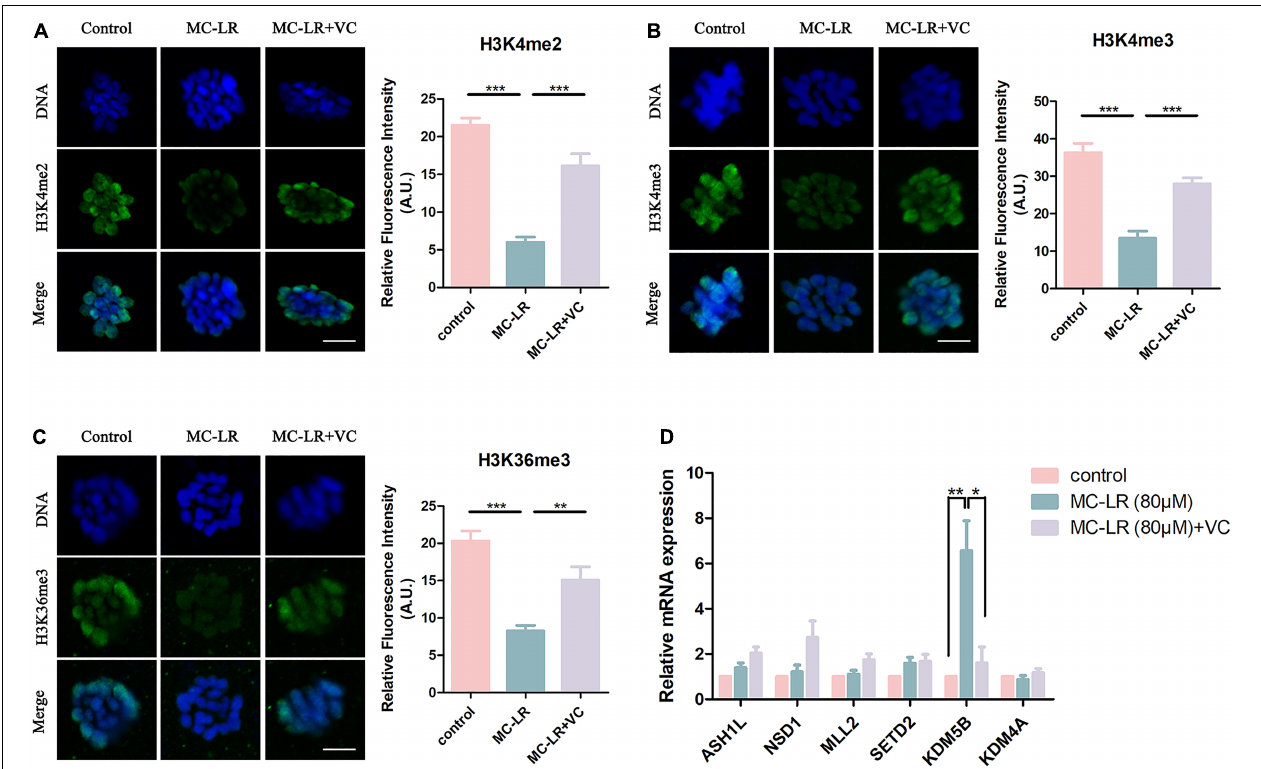
FIGURE 6 | VC can protect oocytes from abnormal epigenetic alterations caused by MC-LR exposure. (A–C) Representative images of H3K4me2, H3K4me3, and H3K36me3 in the control, MC-LR-exposed, and VC-rescued groups. Green, H3K4me2, H3K4me3, or H3K36me3; Blue, chromosomes. Bar = 5 µ m. Quantitative analysis of the fluorescence intensity of H3K4me2, H3K4me3, and H3K36me3 were recorded in graphs. (D) Relative mRNA levels of methyltransferases and demethylases related to histone methylation markers ( ASH1L , NSD1 , MLL2 , SETD2 , KDM5B , and KDM4A ). *Indicates significant difference at p < 0.05 level, ** p < 0.01 level, and *** p < 0.001